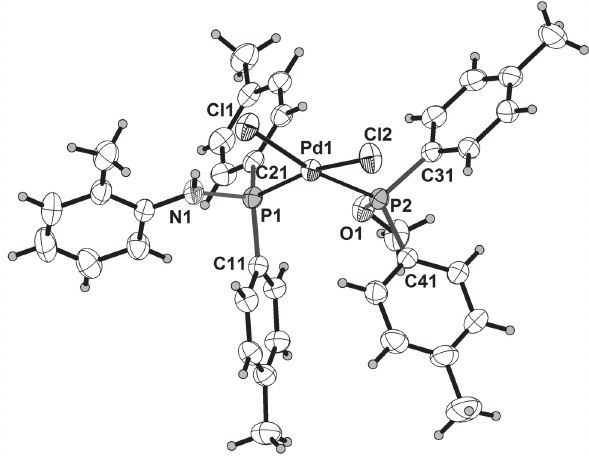
Table 2: Fractional atomic coordinates and isotropic or equivalent isotropic displacement parameters (Å 2